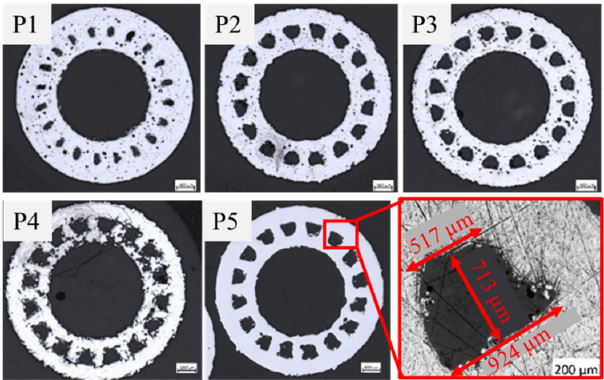
Figure 5. Optical microscopy images of vertically printed trapezoidal grooved wicks with manufac- turing parameters P1 to P5.